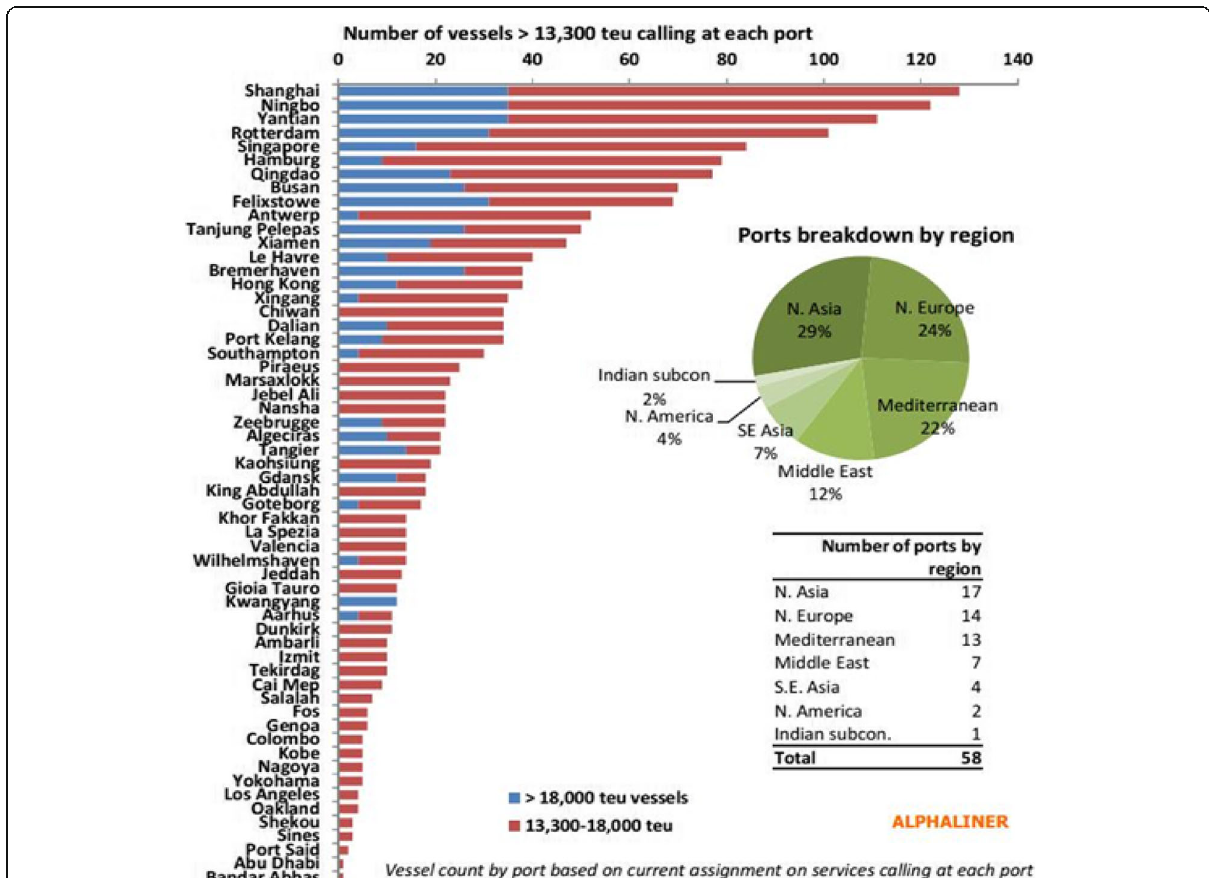
Fig. 1 Receiving ports above 13300TEU as at Dec 2015. (Source: